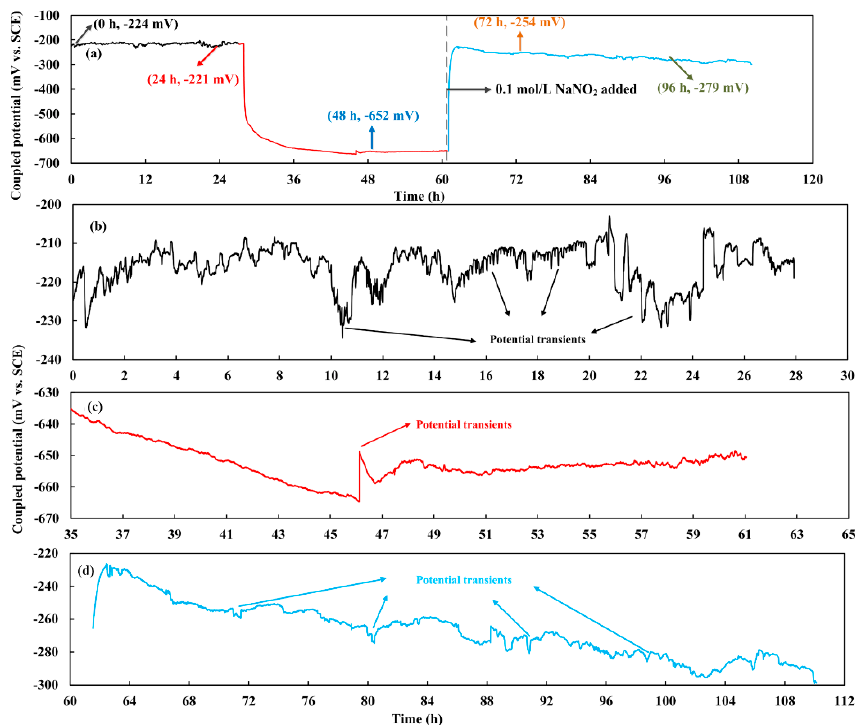
Figure 3. Time dependence of the coupled potential ( a ), the coupled potential at 0 h to 28 h ( b ), the coupled potential at 35 h to 61 h ( c ), and the coupled potential at 61 h to 110 h ( d ).